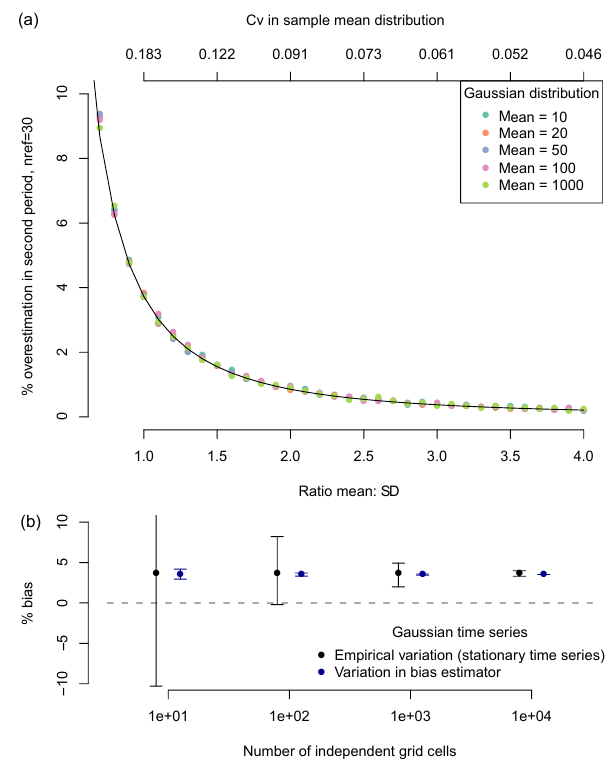
Figure A1. (a) Ratio of mean to SD vs. normalization-induced bias in a Gaussian distribution for numerical simulations with various mean values (dots), and the derived analytical approximation (black line). The reference period length is taken as n ref = 30, and numer- ical simulations are conducted with n = 10 5 grid cells with each 60 time steps. (b) Analytical estimates of biases as calculated from sample mean and sample standard deviation following Eq. (1) in the main text (dark blue) for a given number of independent grid = 1, n = 30). For comparison, the magnitude of random cells ( µ ref σ changes in stationary time series (i.e. empirical variation in the quantity (cid:49) bias , following Eq. A1) with n ref = 30 and n obase = 30 is shown in black. Error bars indicate the 5th to 95th percentile in repeated numerical